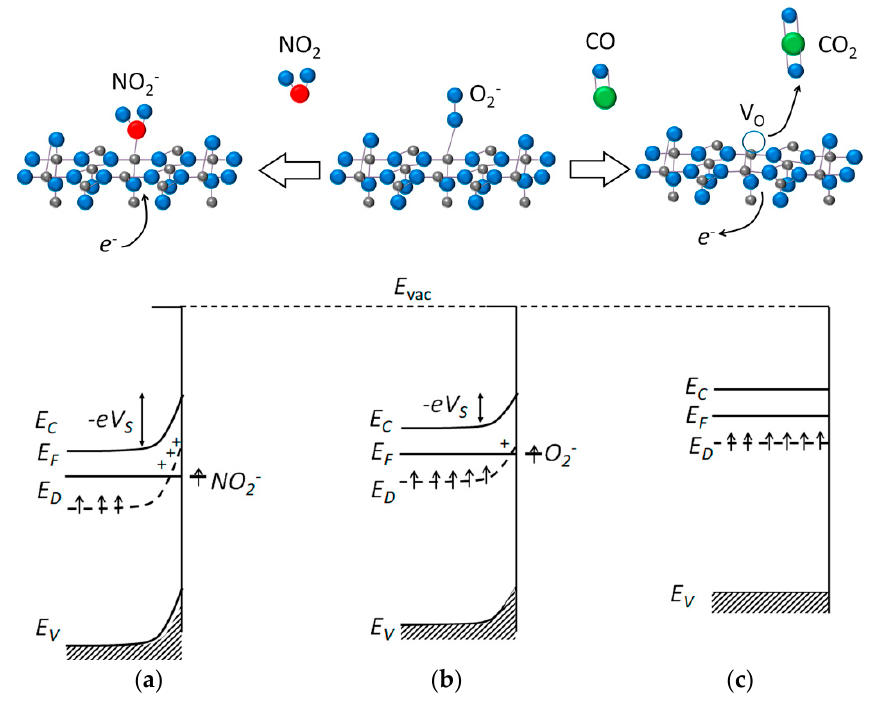
Figure 2. Schematic representation of the surface of n -type MOS with ionosorbed oxygen species ( b ) and after its interaction with reducing gas CO ( c ) and oxidizing gas NO 2 ( a ) within the chemisorption model of sensor response ( top ); and the corresponding modulation of band energy levels ( bottom ).